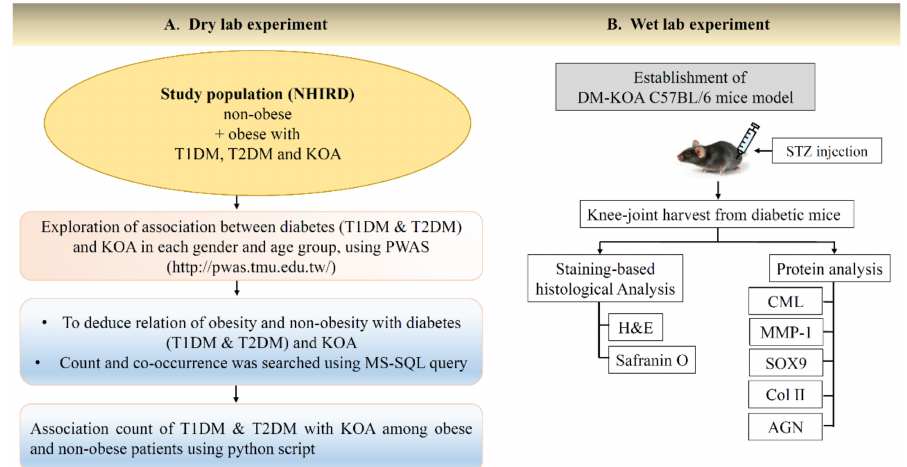
Figure 1. Schematic diagram of dry- and wet-lab experiments investigating the potential correlation between diabetes mellitus (DM) and knee osteoarthritis (KOA). ( A ) Selection of study population from NHIRD, Taiwan for exploration of association between DM and KOA among obese and non-obese subjects. ( B ) Establishment of diabetic KOA in C57BL/6J mice. DM: Diabetes mellitus, T1DM: Type 1